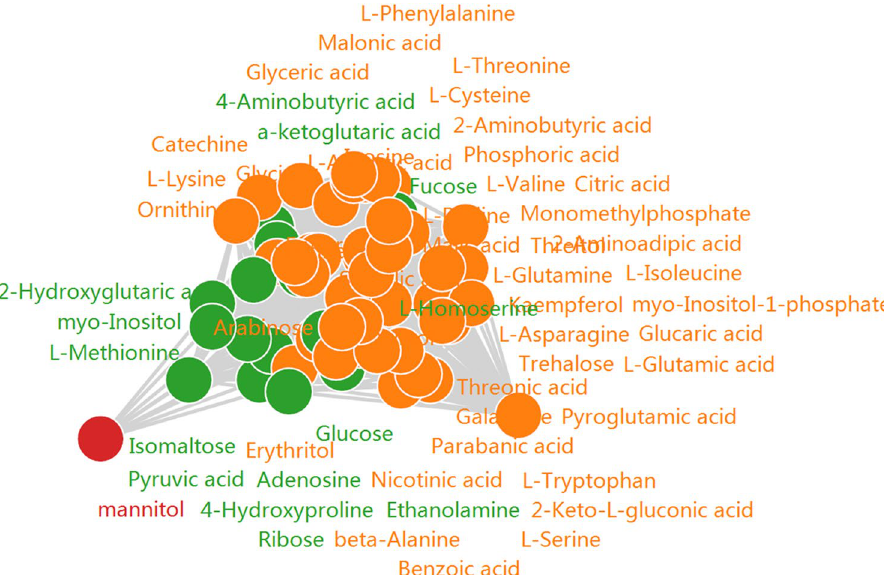
Figure 5. Pearson’s correlation coefficient analysis of DEMs by GC–MS. The correlation coefficient was calculated by Pearson correlation coefficient using the cor() function in R (V3.1.3). The significance statistical test of metabolite correlation analysis was conducted using the cor.test() function in R language package (|R| ≥ 0.7 and FDR p value ≤